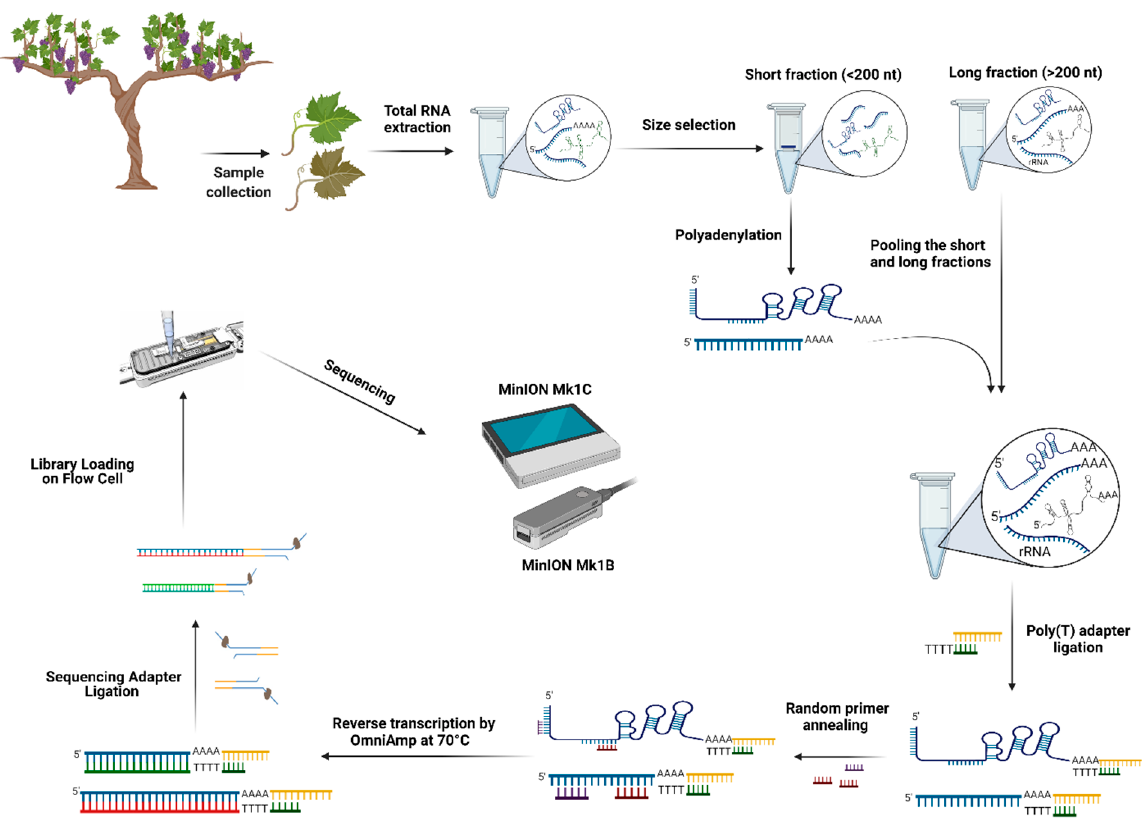
Figure 3. Non-coding RNA and poly(A) tail RNA sequencing in infected grapevine samples by nanopore direct RNA sequencing. Created with BioRender.com (accessed September 15th 2021).